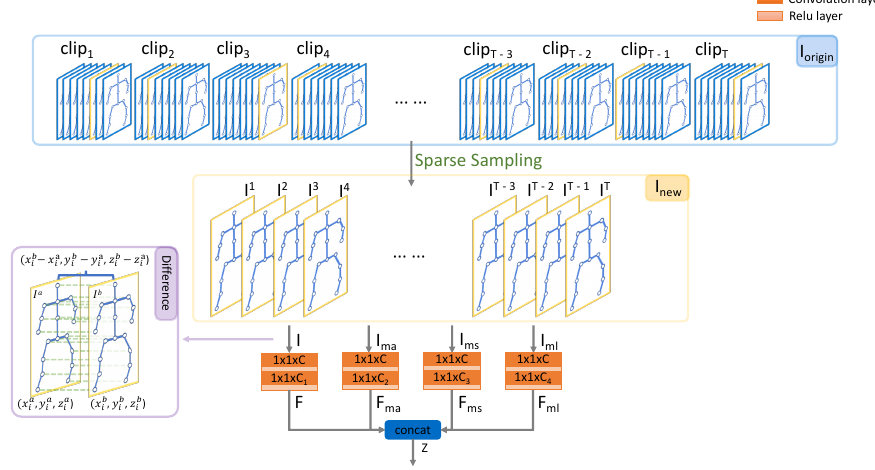
Figure 3. Illustration of dynamics representation (DR). There are four streams of skeleton information embedded into a higher dimension by the embedding block and then concatenated as an input of the spatial relative transformer. Each block consists of two convolution layers and two activation